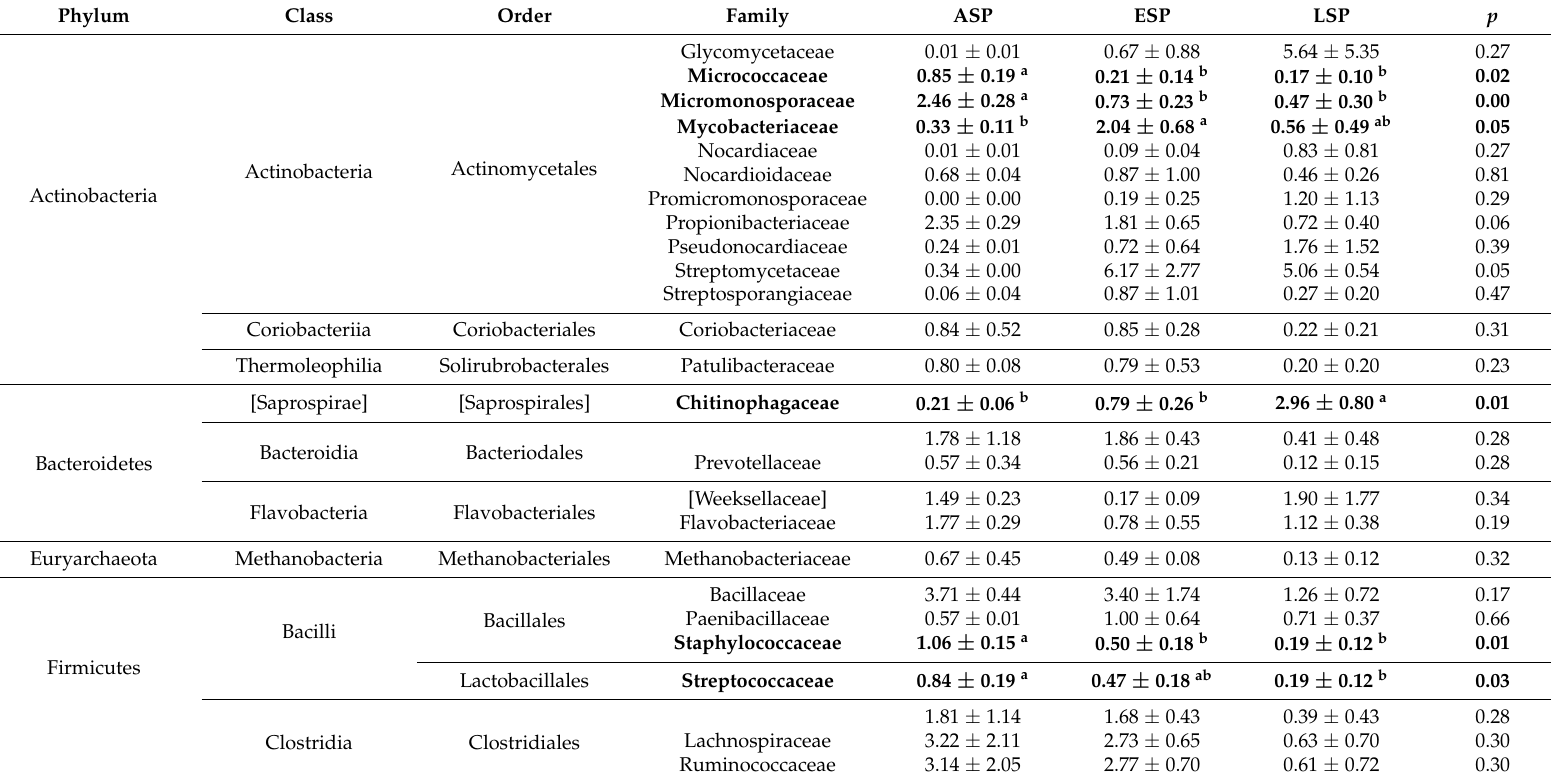
Table 4. Taxonomic relations and relative abundance, with standard deviation, of OTUs at family level in roots. p value is indicated for One-Way ANOVA, followed by Tukey’s exact post-hoc test, carried out to determine significant differences between abundances. Significant differences are highlighted by bold text, and superscript letters ( a,b ) indicate which results are different, while both letters ( a,b ) indicate intermediate